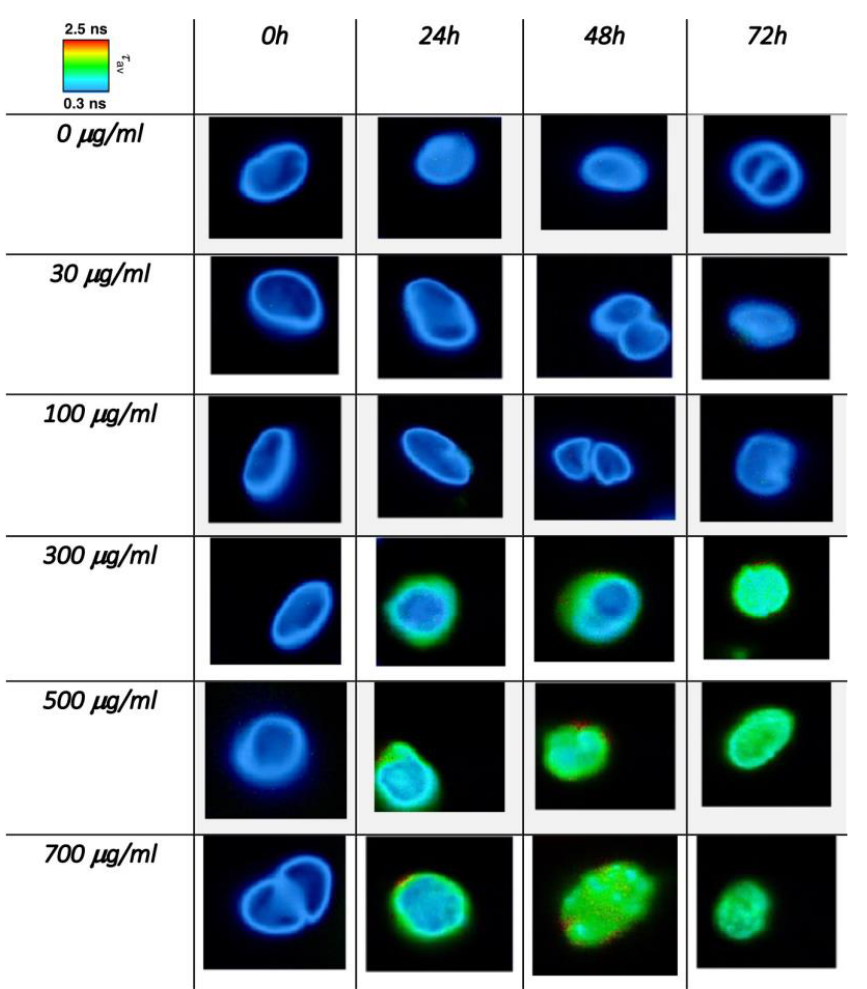
Figure 6. FLIM images of C. cimbrica cell as a function of dose and time. The color scale maps the intensity mediated average fluorescence lifetime (see text for further explanations).